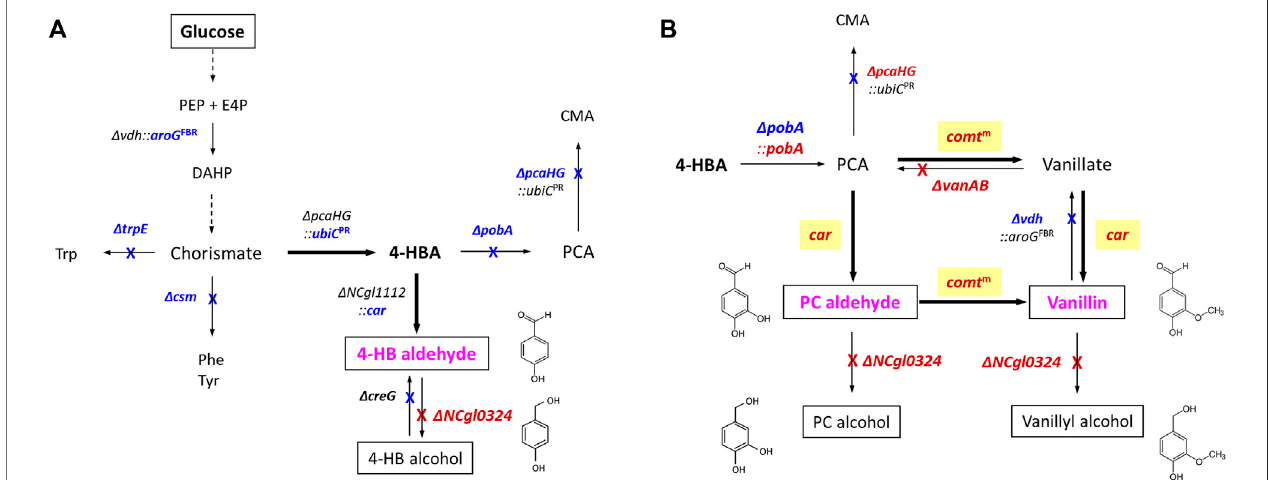
FIGURE 1 | Schematic representation of arti fi cial de novo biosynthetic pathways of 4-hydroxybenzaldehyde. (A) , protocatechuic aldehyde, and vanillin (B) in C . glutamicum .Boldarrowsrepresentarti fi cialcatalyticstepsbyheterologousexpressionofcorrespondinggenes;crossesindicatethedisruptionofcorrespondinggenes. The abbreviations are as follows: PEP, phosphoenolpyruvate; E4P, erythrose 4-phosphate; DAHP, 3-deoxy- D -arabinoheptulosonate-7-phosphate; Phe, L -phenylalanine; Tyr, L -tyrosine; Trp, L -tryptophan; 4-HBA, 4-hydroxybenzoate; 4-HB aldehyde, 4-hydroxybenzaldehyde; 4-HB alcohol, 4-hydroxybenzyl alcohol; PCA, protocatechuate (3,4-dihydroxybenzoate); CMA, β -carboxymuconate; PC aldehyde, protocatechuic aldehyde; PC alcohol, protocatechuic alcohol. Genes and corresponding enzymes are as follows: vdh , vanillin dehydrogenase; aroG FBR , a feedback-resistant DAHP synthase from E. coli ; trpE , anthranilate synthase; csm , chorismate mutase; pcaHG , protocatechuatedioxygenase; ubiC PR , aproduct-resistant chorismate-pyruvate lyase from E. coli ; pobA , 4-hydroxybenzoate hydroxylase; car , carboxylic acid reductase from Nocardia iowensis ; creG , NAD + -dependent dehydrogenase; comt m , a mutant catechol O -methyltransferase (Y200L COMT) from Rattus norvegicus ; vanAB , vanillate demethylase subunits A and B